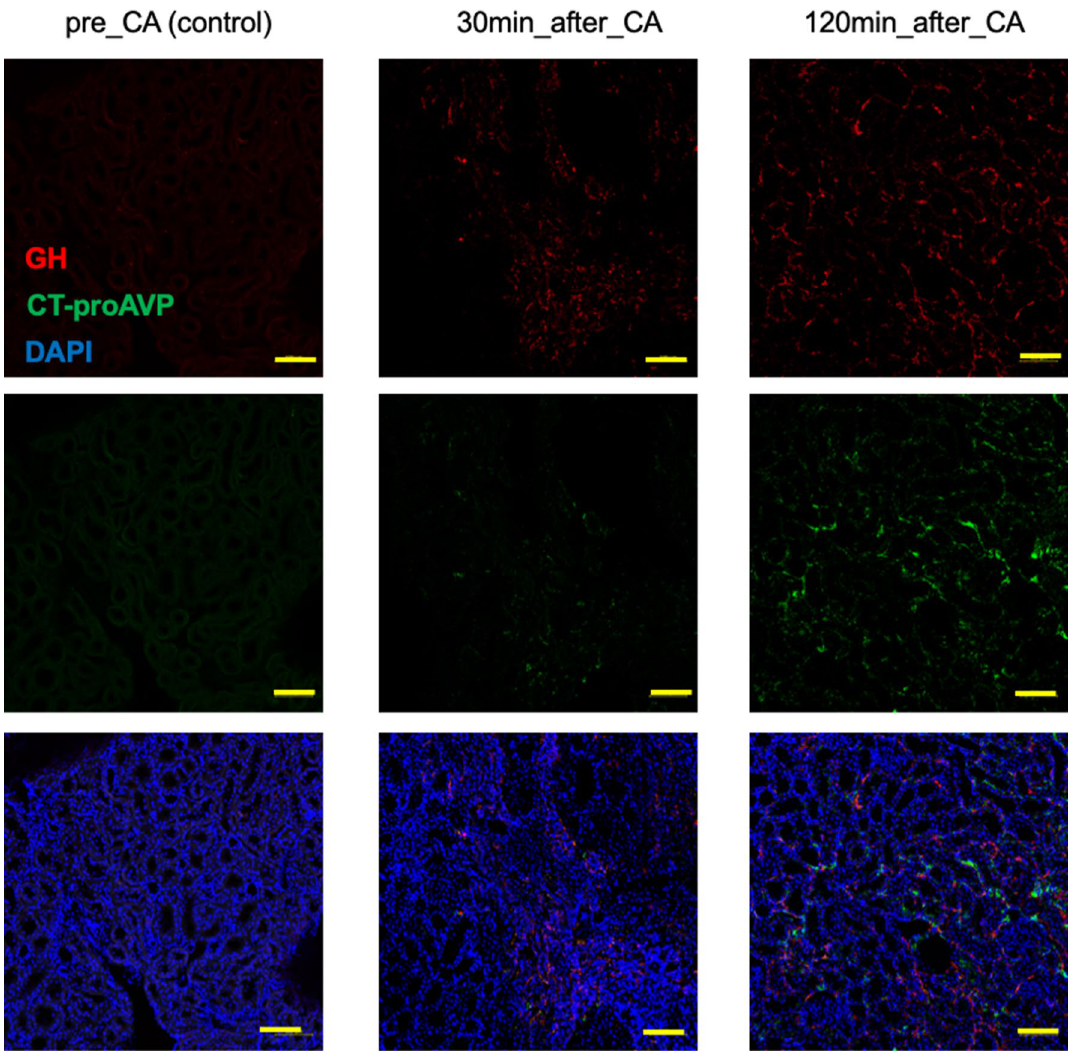
Figure 3. Time-dependent change of copeptin (C-terminal portion of pro-arginine-vasopressin: CT-proAVP) and growth hormone (GH) in the kidney of the rat with asphyxial cardiac arrest. The kidney sections were double-immunostained with anti-CT-proAVP and anti-GH antibodies, followed by AlexaFluor 555-labeled and AlexaFluor 488-labeled secondary antibodies respectively. 4, 6-Diamido-2-Phenylindole (DAPI) staining was performed to show the cell nuclei. LPF, low power field. LPF of the pituitaries at different time points. Scale bars meant 100 um (yellow). There seemed a difference between the absorbed site of CT-proAVP and that of